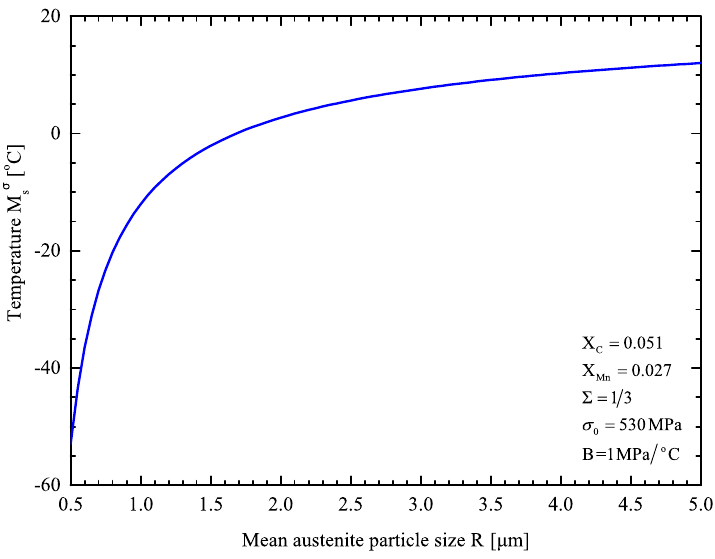
Figure 8. M σ s temperature as a function of mean austenite particle in retained